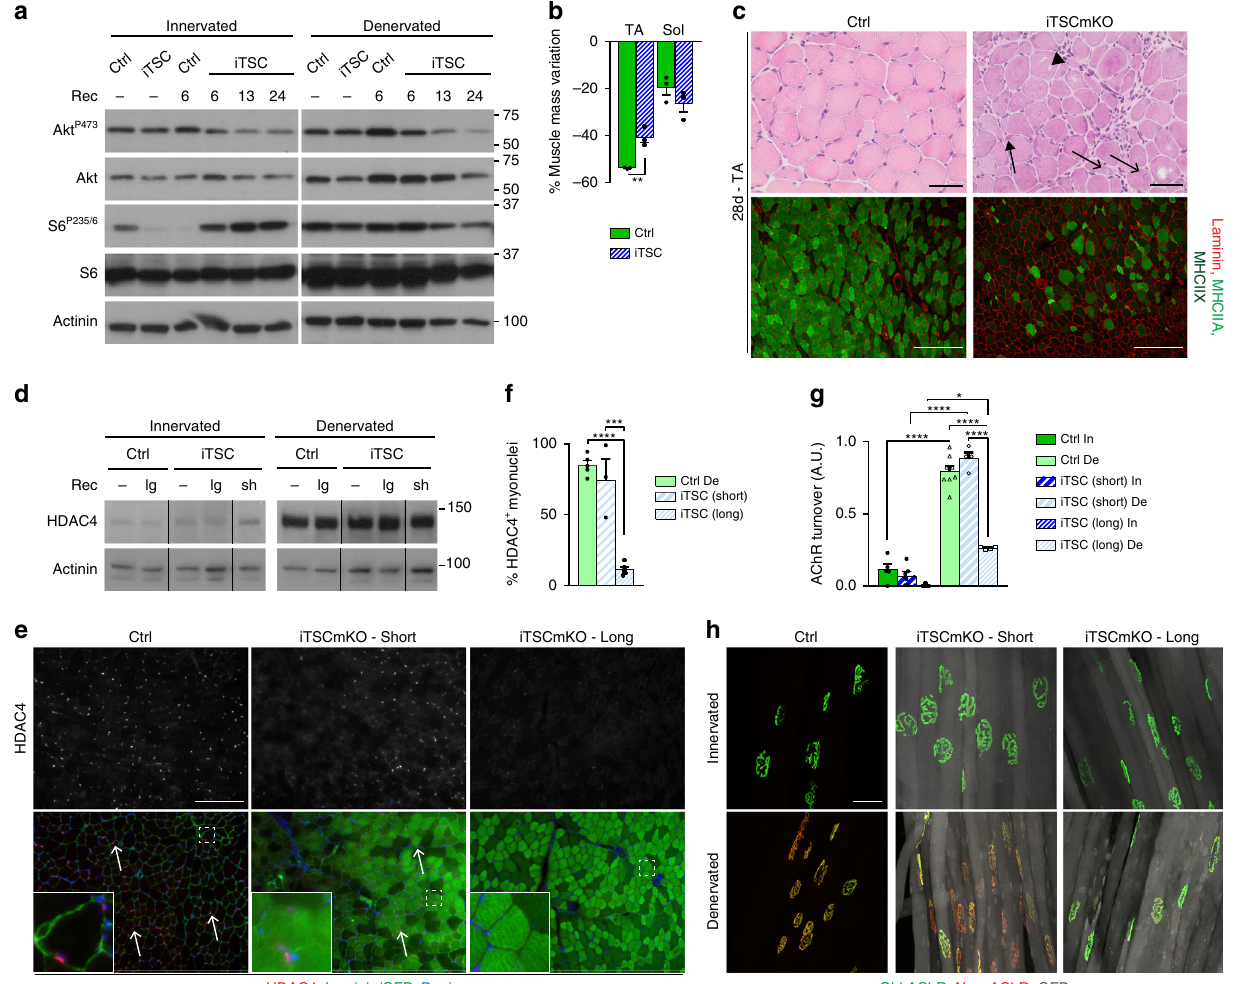
Fig. 6 Acute mTORC1 activation impairs HDAC4 function and limits AChR turnover. a Western blot analysis of total and phosphorylated levels of PKB/Akt and S6 in TA innervated and 3-day-denervated control (Ctrl) and iTSCmKO (iTSC) muscles, without tamoxifen treatment ( − ), or 6, 13, and 24 days after recombination induction (Rec). n = 3 (untreated, 6 and 13d) and 5 (28d) iTSCmKO mice. b Mass variation for TA and soleus (Sol) muscles in control and iTSCmKO mice, after 28 days of denervation, as compared to contralateral innervated muscle. n = 3 per group. c HE coloration (top panel) and fl uorescent pictures of MHCIIA/X (bright/dark green) and laminin (red) immunostaining (lower panel) of TA denervated (28d) muscle from control and iTSCmKO mice. Representative of 3 independent muscles per group. Arrows, arrowhead and open arrows point to intracellular aggregates, vacuoles and abnormal giant nuclei, respectively. Scale bar, 50 (top) and 200 (bottom) µ m. d Western blot analysis of HDAC4 in innervated and denervated (3d) control and iTSCmKO mice after short (sh) or long (lg) recombination induction. e , f Fluorescent pictures of HDAC4 (red) and laminin / GFP (green) of 3-day- denervated TA muscle from control and iTSCmKO mice with short or long recombination induction. Arrows point to HDAC4-positive myonuclei. Scale bar, 100 µ m. Quanti fi cation in ( f ) gives the proportion of HDAC4-positive myonuclei. n = 5 Ctrl, 3 (short) and 5 (long) iTSCmKO muscles. g , h AChR turnover quanti fi cation for control and iTSCmKO mice with short or long recombination induction. n = 4/5/3 (In) and 7/3/3 (De) Ctrl, short and long iTSCmKO muscles. Representative pictures of “ old ” (green) and “ new ” (red) AChRs is given in ( h ). GFP appears in gray in iTSCmKO fi bers. Scale bar, 50 µ m. All values are mean ± s.e.m; two-tailed unpaired Student ’ s t- test ( b ), or one- ( f ) or two- ( g ) way ANOVA with Tukey ’ s post-hoc test, * p < 0.05, ** p < 0.01, *** p < 0.001, **** p < 0.0001. Western blot quanti fi cations are shown in Supplementary Table 1. Source Data are provided in the Source Data muscle (Fig. 7e). Thus, we next combined HDAC4 overexpression state of PKB/Akt (Fig. 8a), we tested whether PKB/Akt inhibition with the measurement of AChR turnover in denervated TSCmKO would be responsible for HDAC4 defects and endplate degen- muscle. Importantly, AChR turnover was strongly increased in eration in TSCmKO muscle. To test this, we used transgenic mice HDAC4-transfected fi bers from TSCmKO muscle, but remained (Akt1-TG mice) expressing an active, myristoylated form of Akt1, low in GFP-electroporated mutant fi bers (Fig. 7f, g). These results fused with EGFP and ERT2. In the absence of tamoxifen, the indicate that defective HDAC4 activity contributes to the loss of fusion protein is immediately degraded, while the binding of neuromuscular endplates upon denervation in TSCmKO muscle. tamoxifen to ERT2 renders the protein stable. Thus, injection of tamoxifen leads to the immediate activation of PKB/Akt, which in turn strongly activates mTORC1 (Fig. 8b). Hence, mTORC1 activation is similar in Akt1-TG and TSCmKO muscles, while PKB/Akt activation promotes HDAC4 and endplate remodel- PKB/Akt is active in Akt1-TG muscle, but inhibited in TSCmKO ing . Since control and TSCmKO muscles both show strong muscle (Fig. 8a). Activation of Akt1 for 2 weeks was suf fi cient to mTORC1 activation upon denervation, but differ in the activation